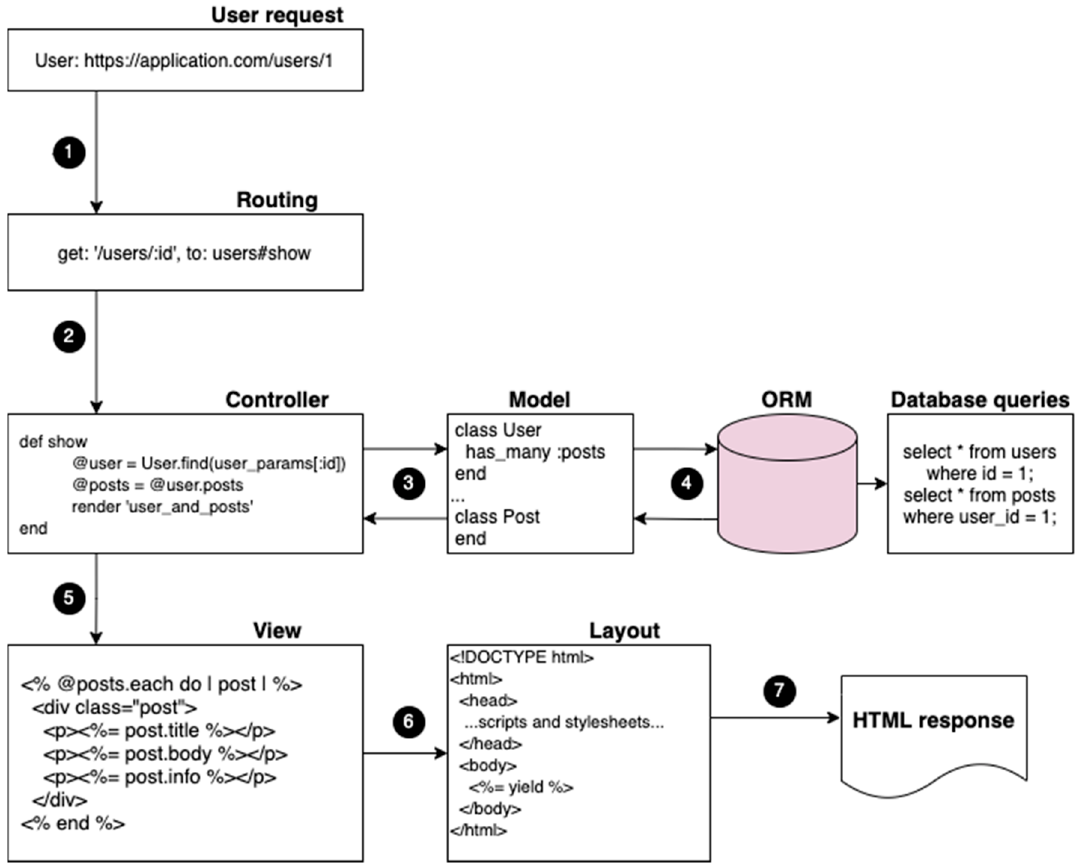
Figure 1. Web application server request handling process in a traditional Rails Application.